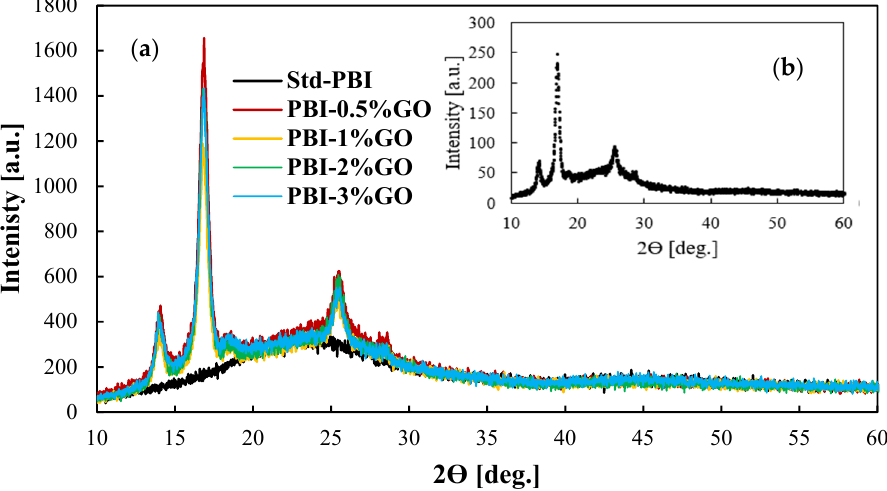
Figure 2. ( a ) XRD patterns of GO composite PBI-based membranes with different content of GO; ( b ) XRD pattern for the GO particles. Table 1. Values of the thickness increase, ADL, and phosphoric acid retention of the studied PBI